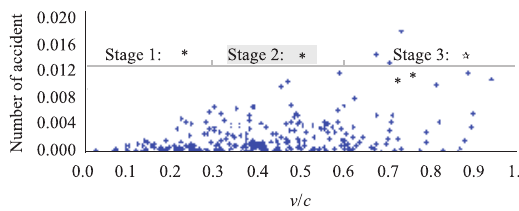
Fig. 3. Accident distribution at peak hours in responce to v / c Note: * ¶ denotes high frequency and low